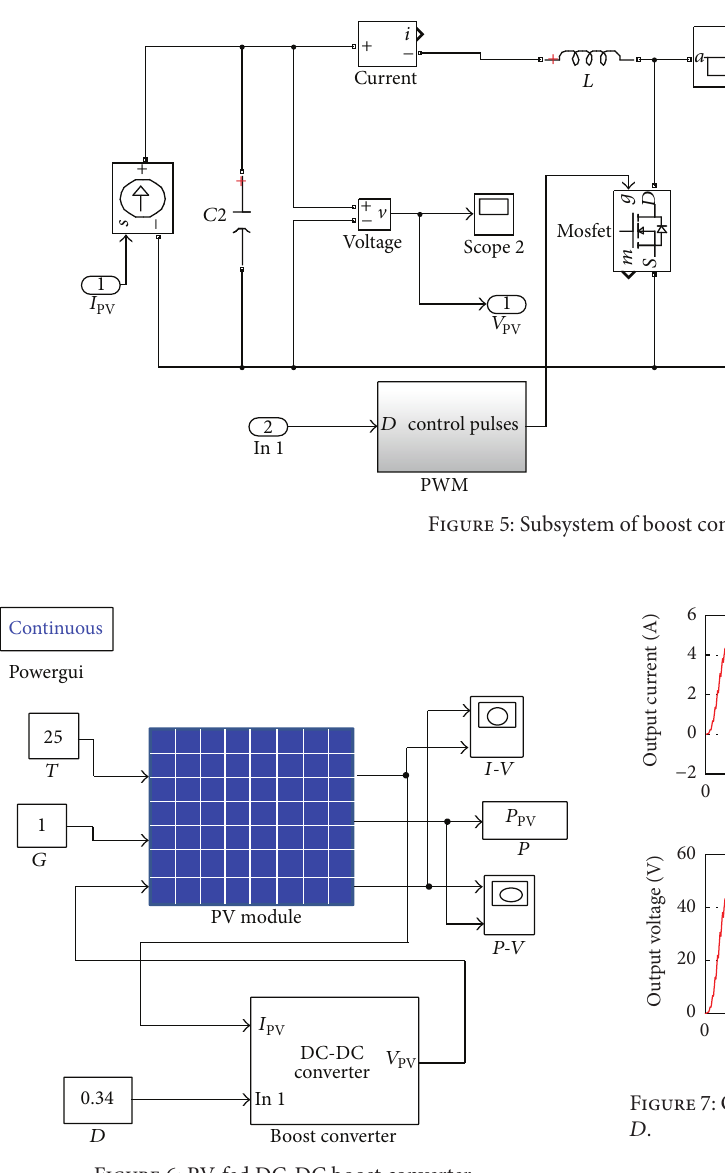
Figure 6: PV-fed DC-DC boost converter.